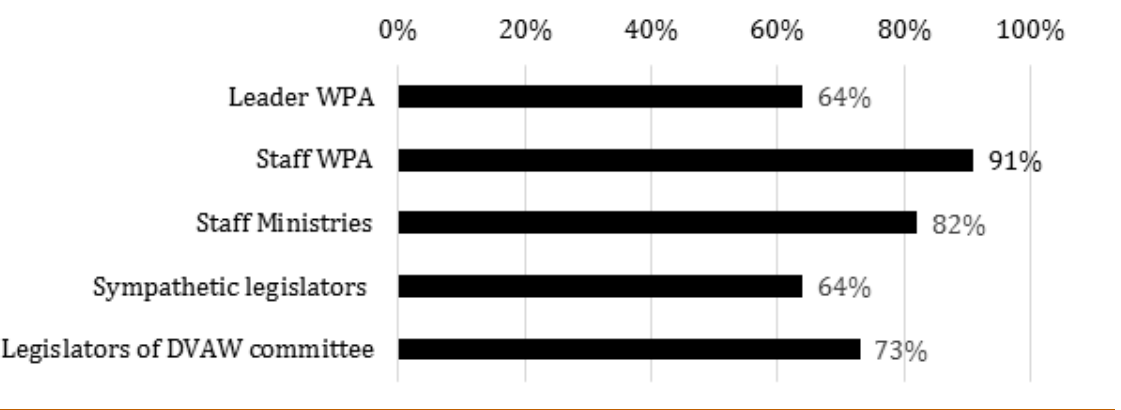
Source: Author’s own